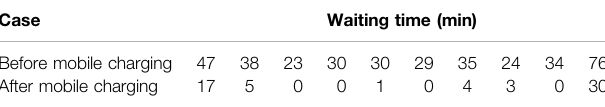
TABLE 1 | Comparison of the waiting time before and after mobile charging. Case